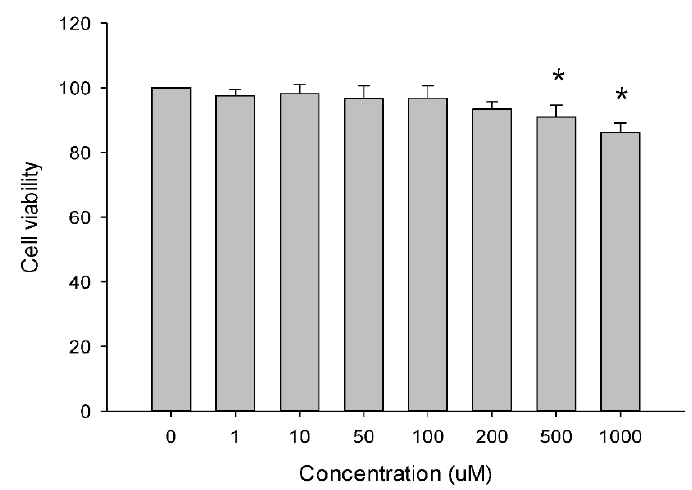
Figure 6. Cytotoxicity of KAU in Caco-2 cells by CCK-8 assay (mean ± SD, n = 6). * p < 0.05.